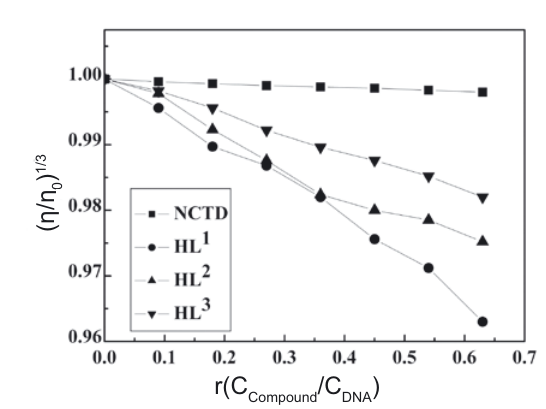
r(C /C ) Compound DNA Figure 3. Effect of increasing amounts of compounds on the relative viscosities of ct-DNA at 30 o C. [DNA] = 3.72 × 10 -4 mol L -1 , r = [compound]/[DNA]. (1): r = 0; (2): r = 0.09; (3): r = 0.18; (4): r = 0.27; (5): r = 0.36; (6): r =